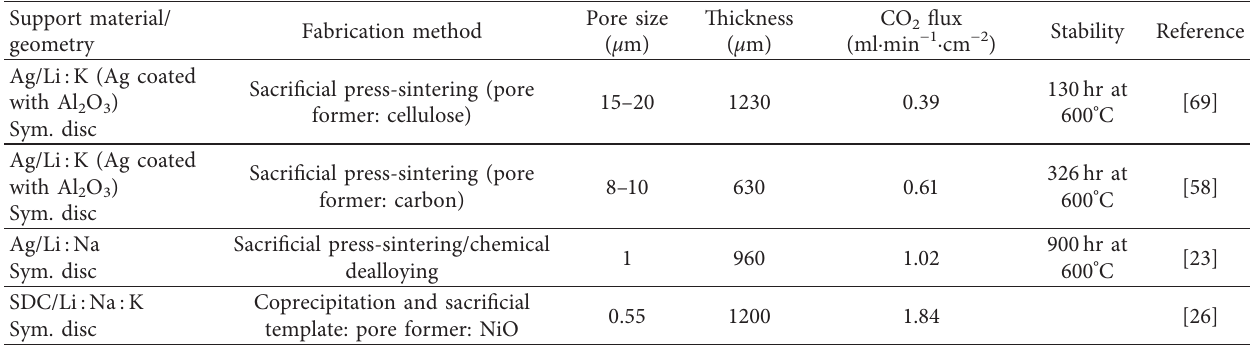
Table 7: Effect of feed/sweep gas on CO